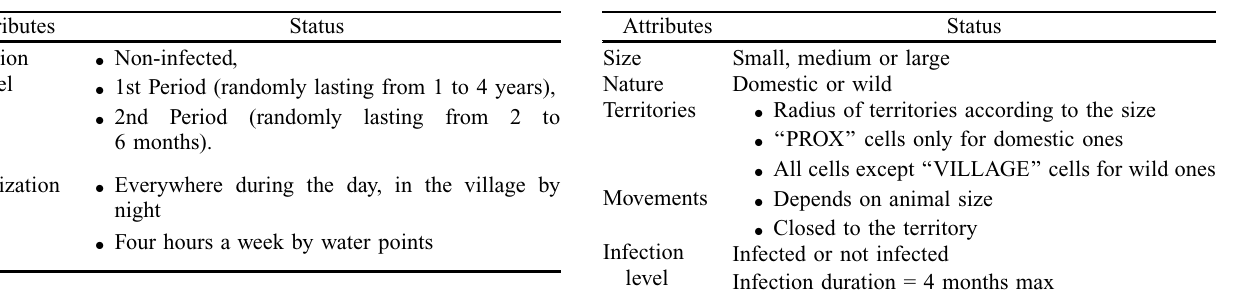
Table 1. Attributes and status of human agents. Table 2. Attributes and status of animal